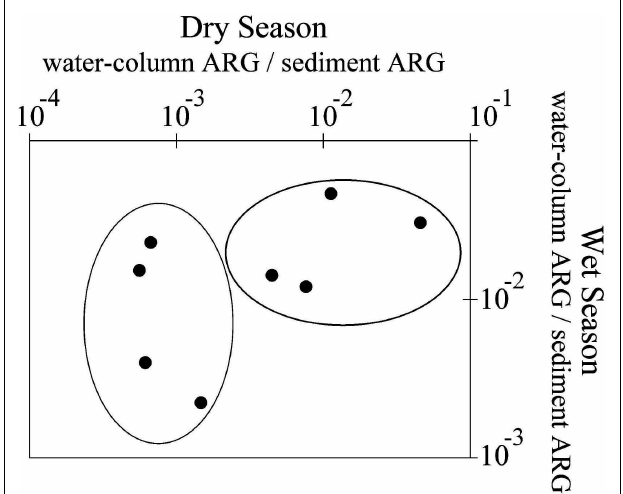
FIGURE 4 | Ratio of water column-to-sedimentARG abundances (all genes; log -transformed) at each station, plotted according to season. Water column and sediment data were normalized to common sample